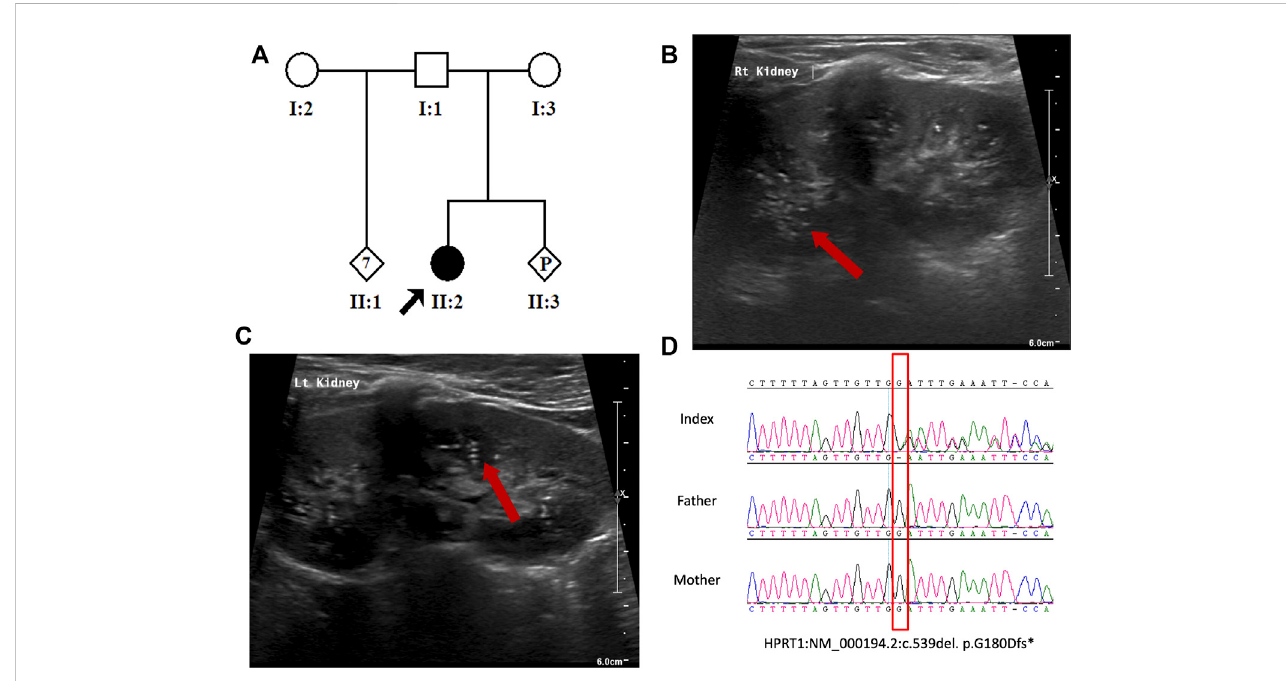
FIGURE 1 (A) Pedigree of the study family. (B,C) Abdomen US indicating bilateral echogenic foci within the renal collecting system. (D) Sanger sequence chromatogram showing the heterozygous HPRT1 variant (NM_000194.2:c.539del. p. G180Dfs*10) in the patient and wild-type sequence in her